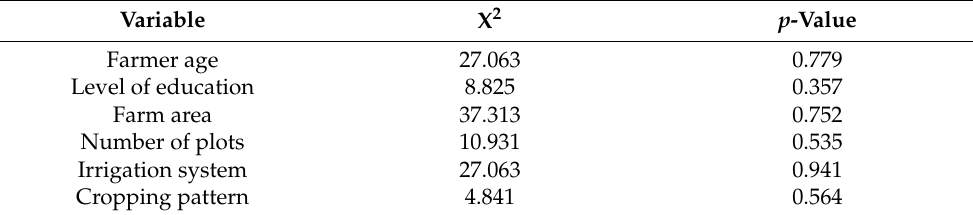
Table 5. Pearson chi-square test results for each farmer profiling variable.